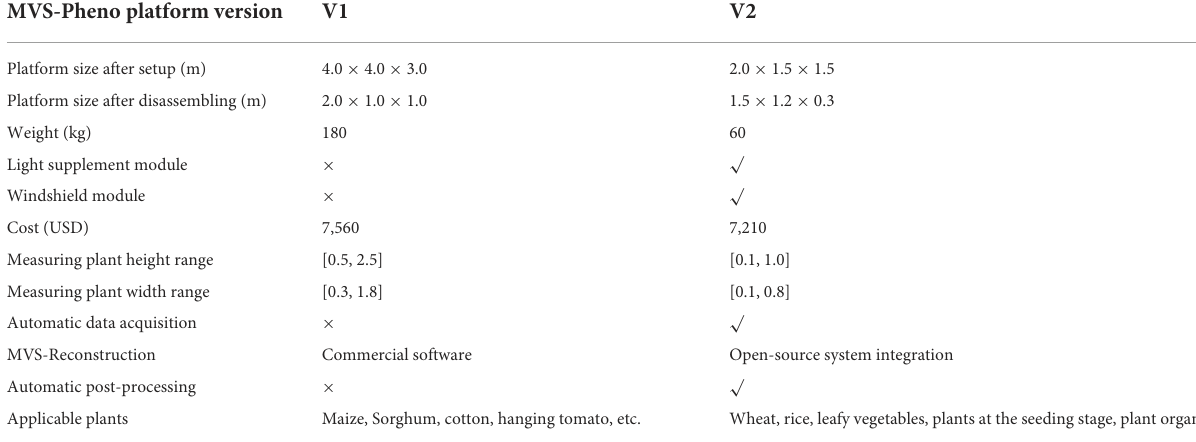
TABLE 2 The MVS-Pheno platform parameters and performance comparison between V1 and V2. MVS-Pheno platform version Platform size after setup